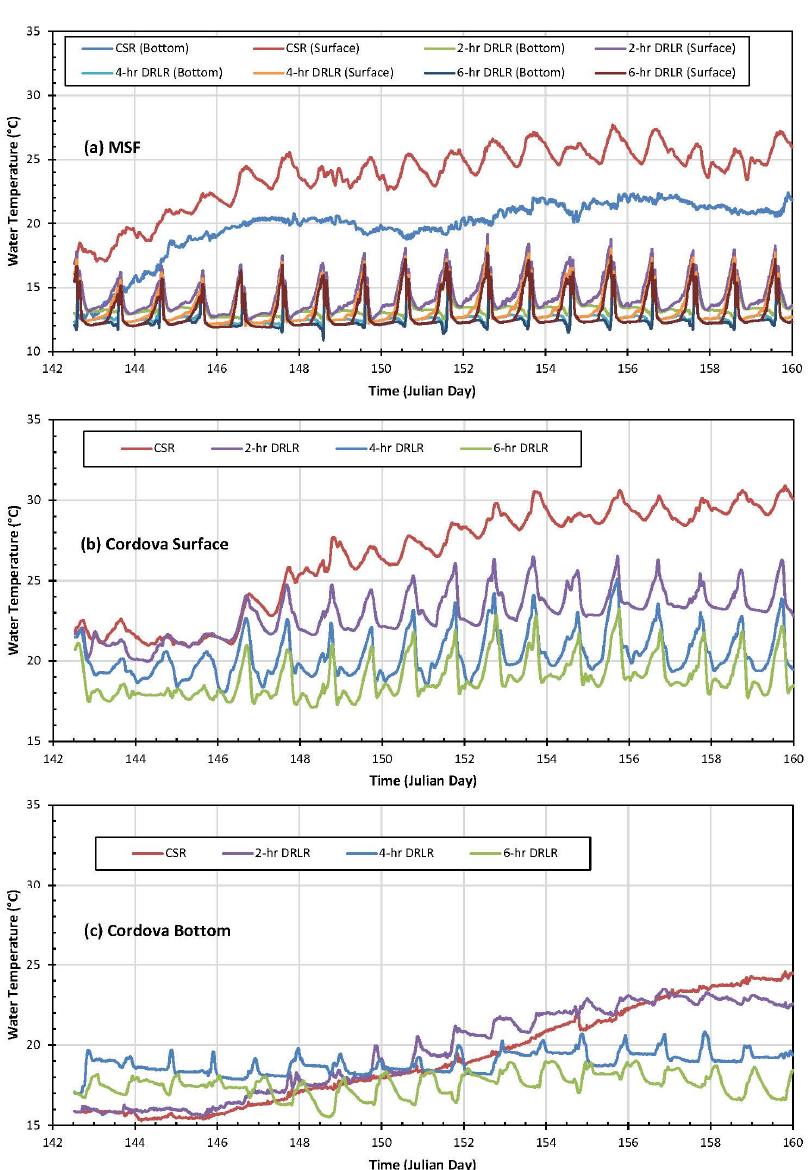
Figure 9. Time series of simulated water temperatures in the surface and bottom layers at MSF and Cordova for CSR only, 2-, 4- and 6-h DRLRs. ( a ): MSF; ( b ): Cordova Surface; ( c ): Cordova